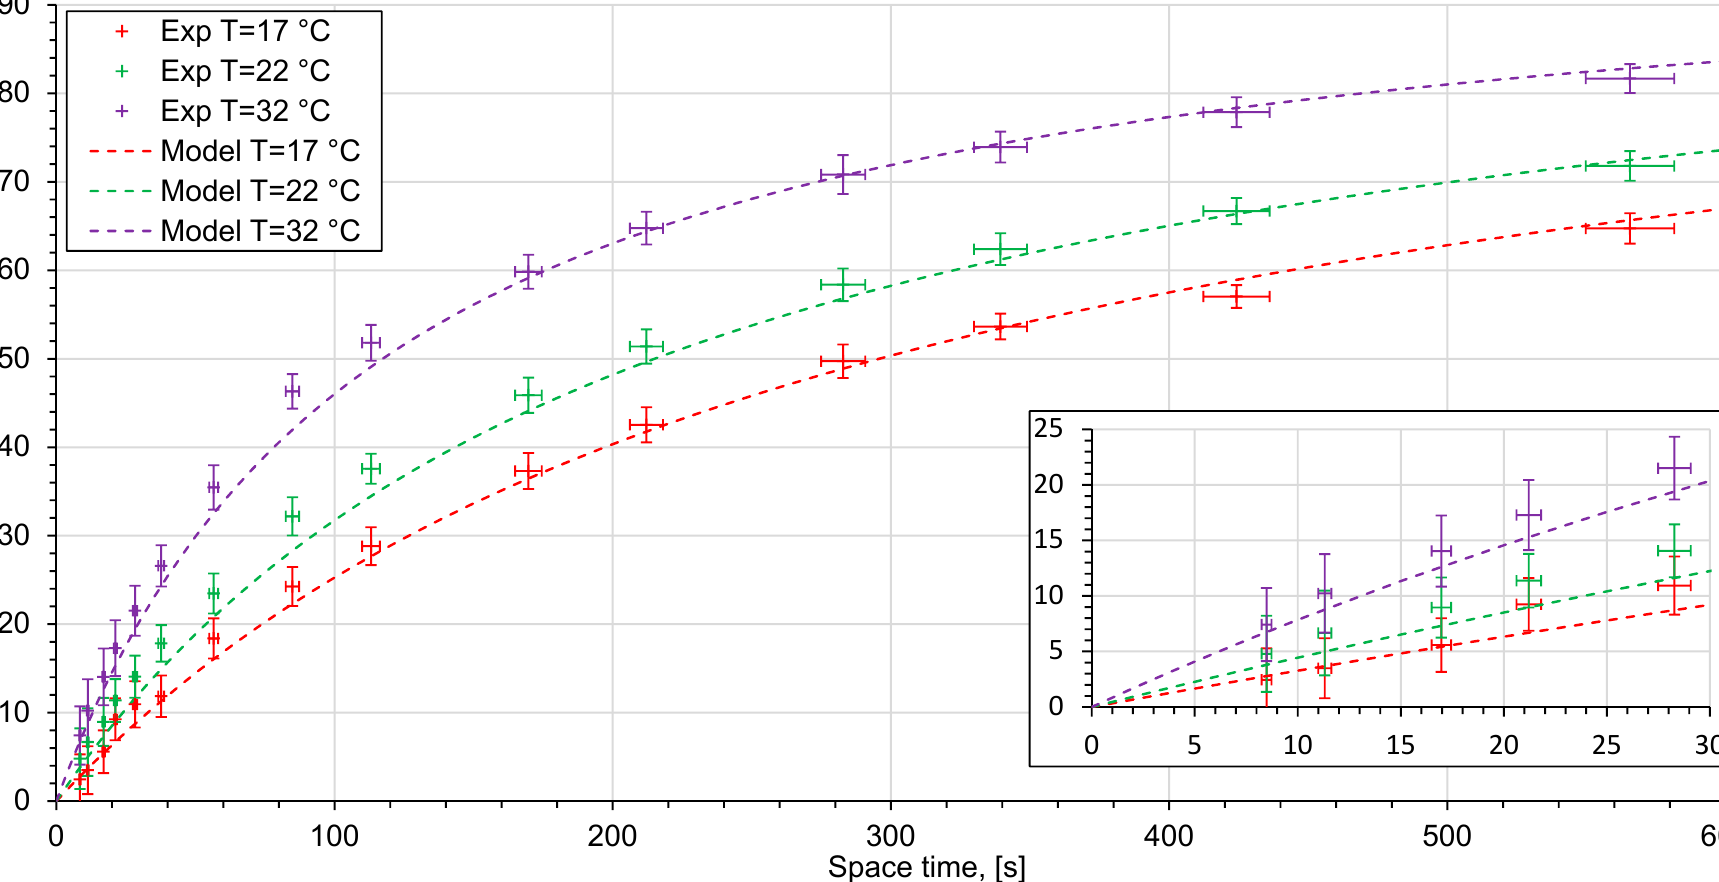
Figure 9. Experimental data (crosses) and kinetic model (dashed lines) at different temperatures in the reactor system with a chicane microreactor.